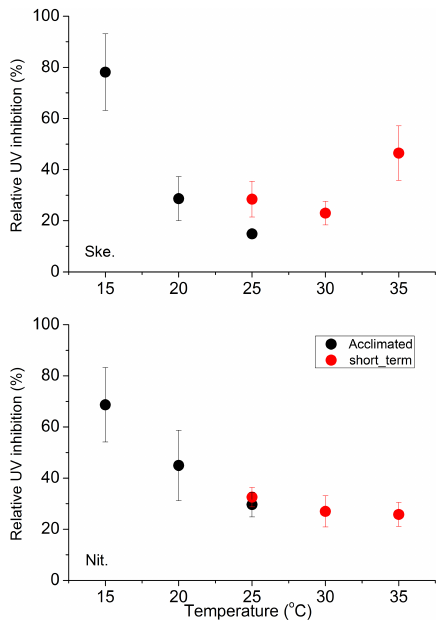
Figure 4. The relative UV inhibition on the photosystem II of Skele- tonema sp. (a) and Nitzschia sp. (b) under grown or short-term ele- vated temperature. Vertical lines represent